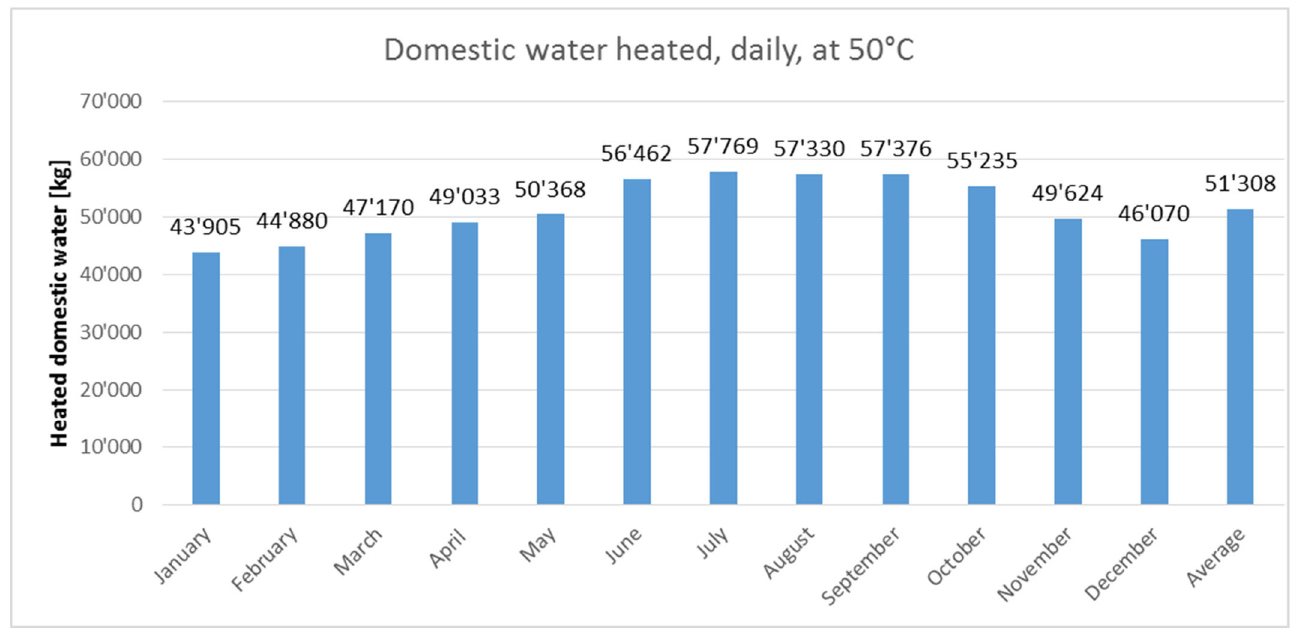
Figure 11. Domestic water mass that can be, on average, heated, daily, at 50 °C.